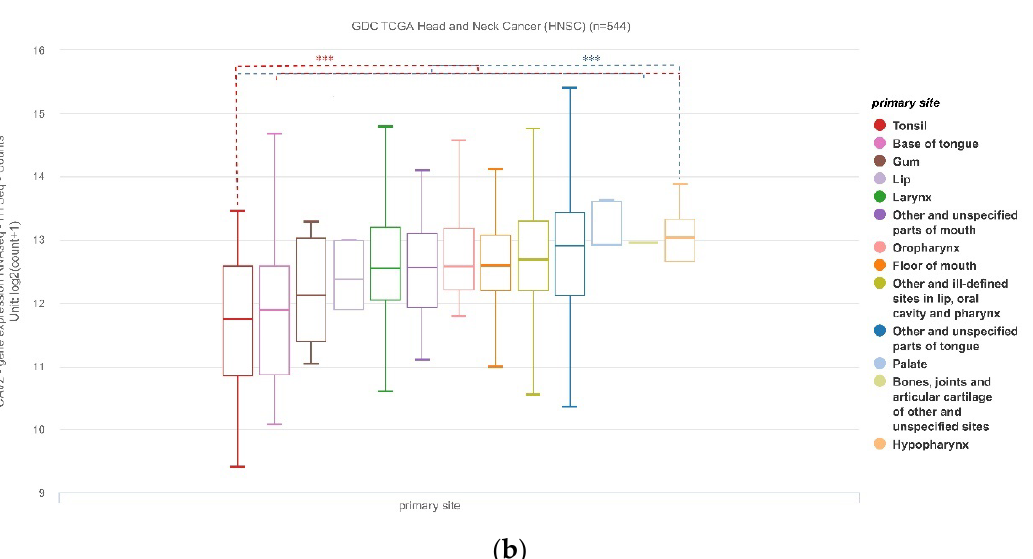
Figure 5. HNSCC contains tumors from multiple sites, including tonsil, hypopharyngeal, palate and oropharynx, etc. ( a ) Expression of CAV1 at different sites, with the lowest in tonsil and highest in the palate ( p < 0.001); ( b ) Expression of CAV2 at different sites, with the lowest in tonsil and highest in the hypopharynx ( p < 0.001).